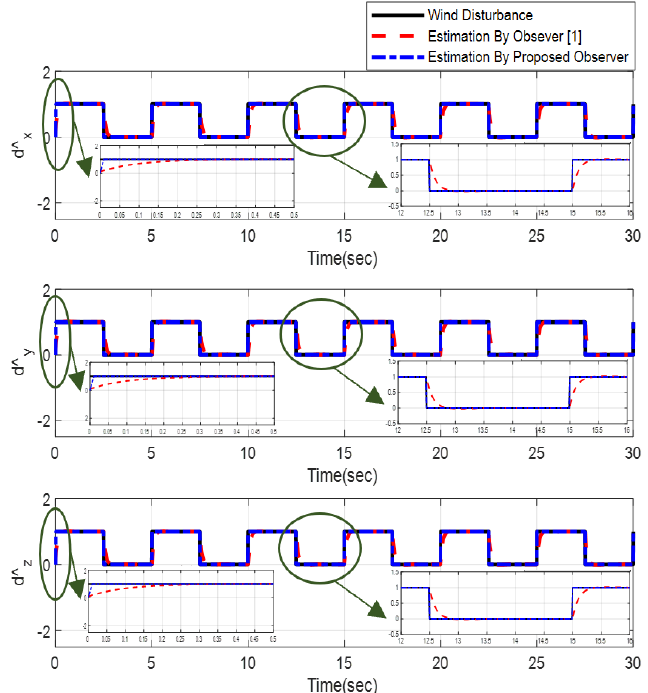
Figure 10. Estimation of the wind perturbation entered to the position of quadrotor.